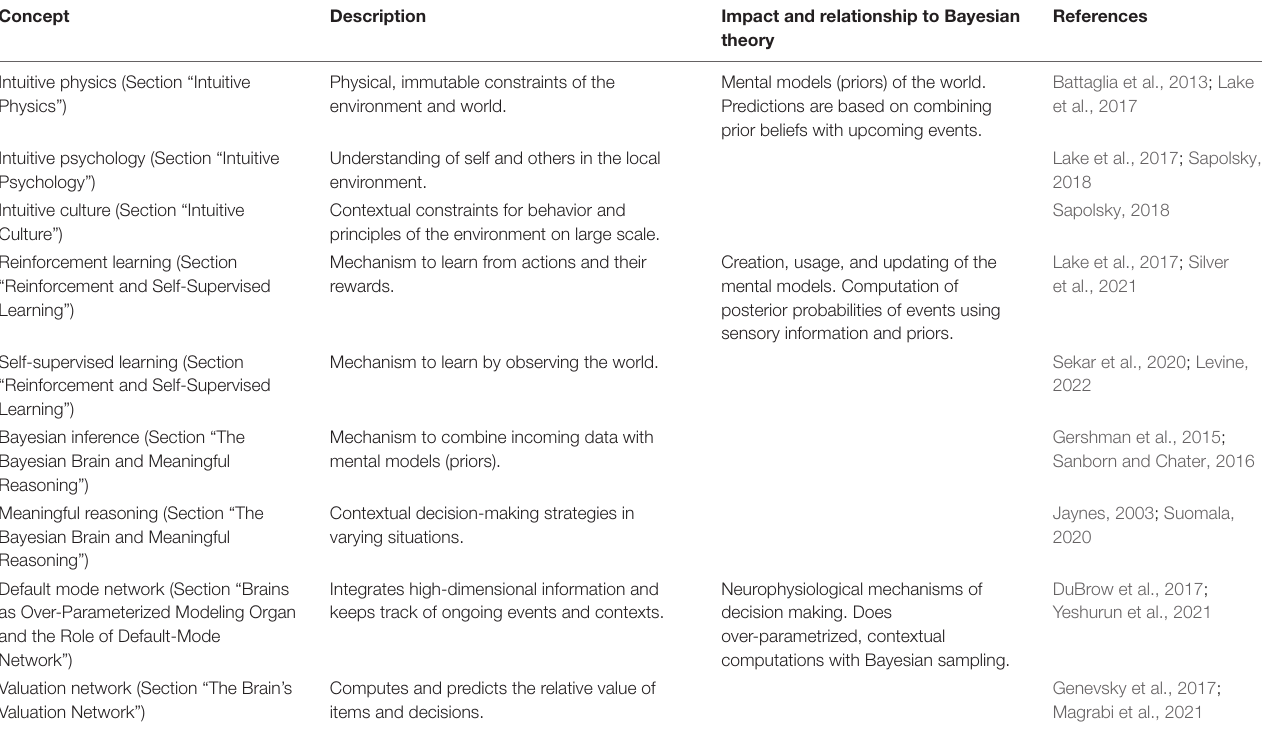
TABLE 1 | Key concepts from artificial intelligence, behavioral sciences and neurosciences from Bayesian theory perspective as discussed in this